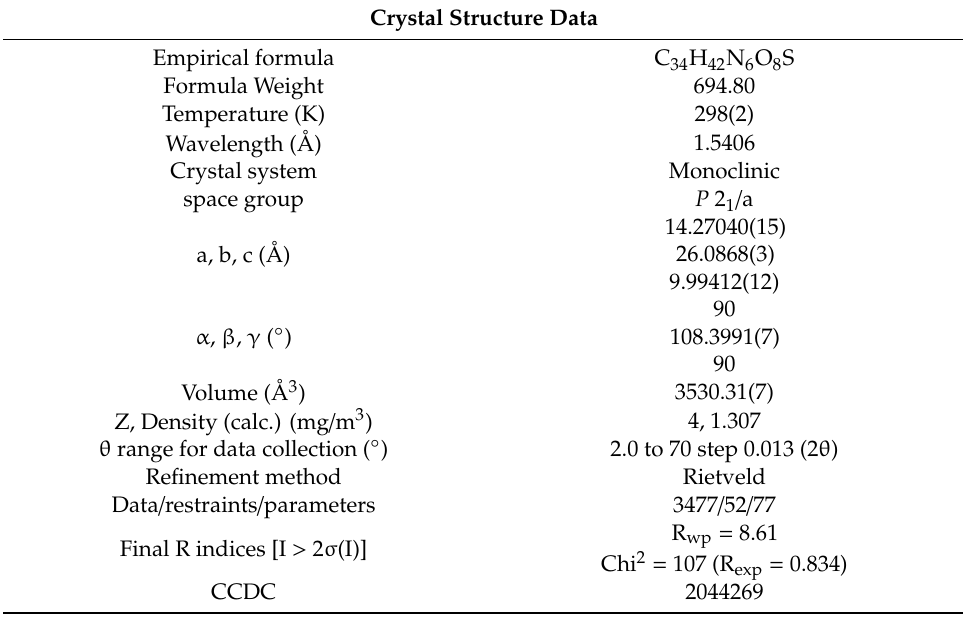
Table 1. Crystal data and structure refinement parameters for Sildenafil resorcinol